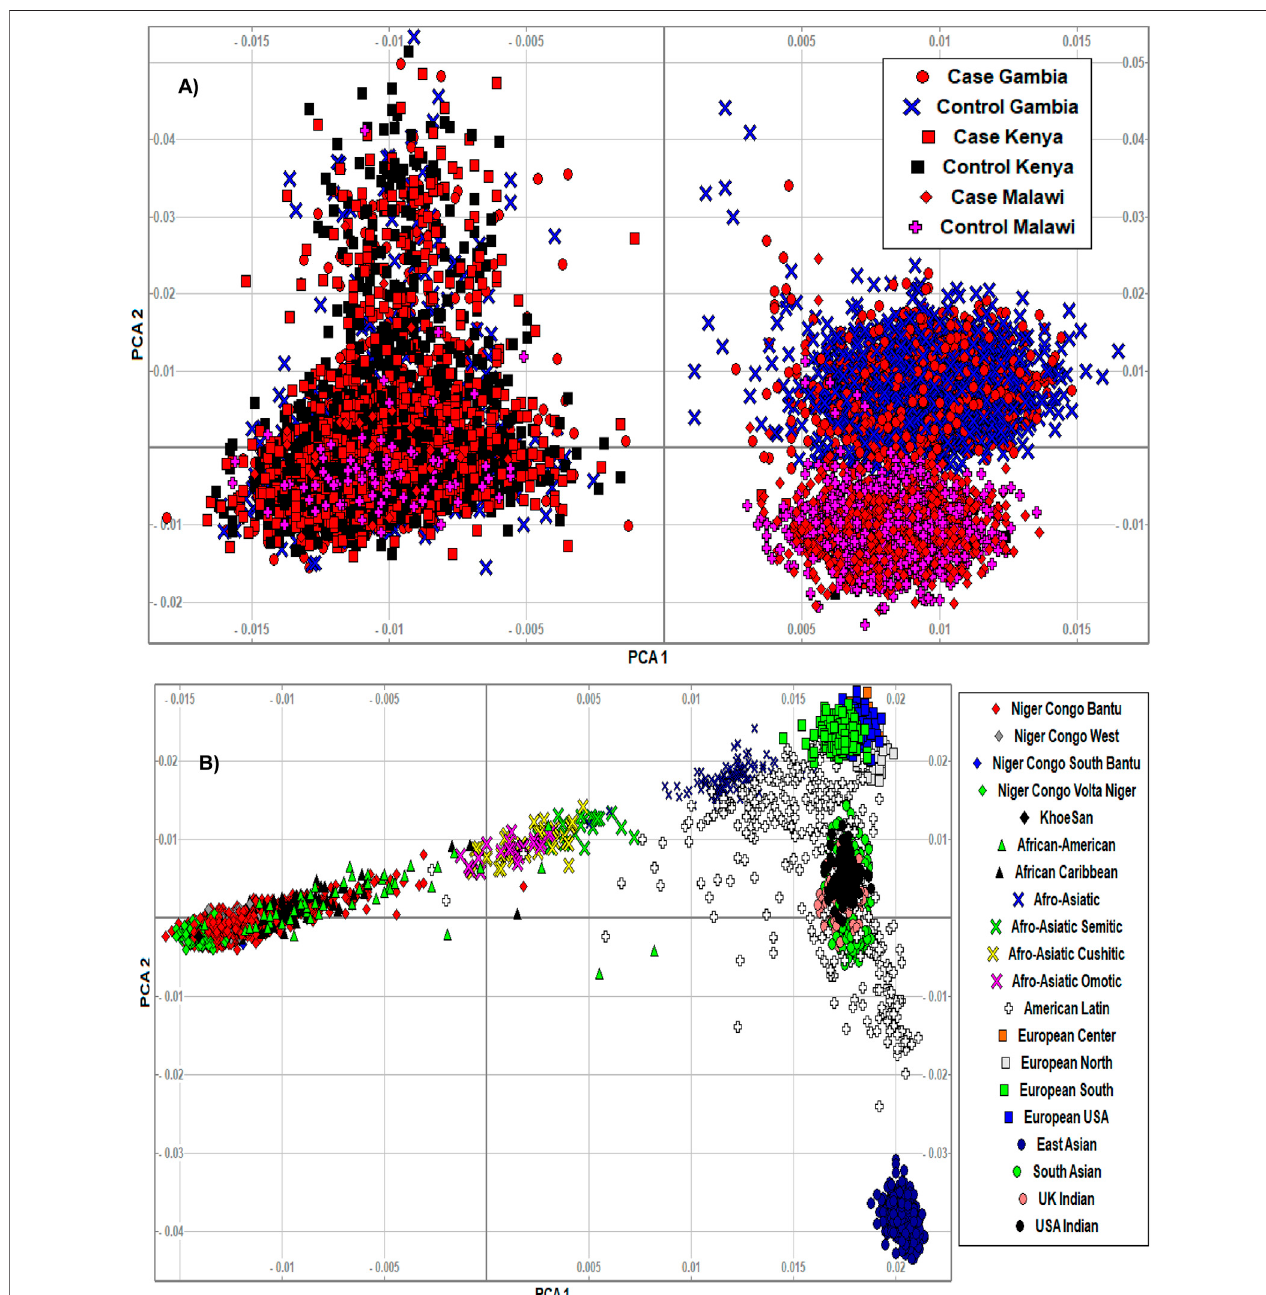
FIGURE 5 | (A) We clustered the merged malaria GWAS dataset containing only SNPs residing in the identi fi ed malaria resistance candidate genes ( N (cid:1) 10,578 samples,15,675SNPs)usingsmartpcasoftware.Thepopulationswereindicatedbydifferentcoloursandsymbols.ThePCAanalysiseffectivelyclusteredthemajorityof the populations according to their ancestry, suggesting that the variants in the candidate genes are differentiated across ethnic background. The three populations and theircase/controlstatuswereindicatedbydifferentcoloursandsymbols. (B) WeclusteredtheAGVPdatasetcontainingonlySNPsresidingintheidenti fi edmalaria resistance candidate genes ( N (cid:1) 4,932 samples, 93,5549 SNPs) into sub-regions/populations using smartpca software. The populations were indicated by different colours and symbols. The populations were clustered based on their geographical locations. However, the clusters in Malawi and Gambia slightly overlapped, likely because of the similar malaria endemicity in these